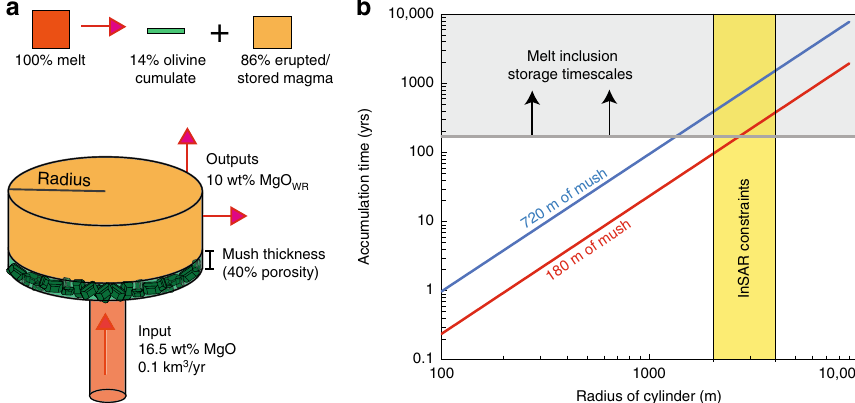
Fig. 10 Estimating mush pile accumulation rates using a simple box model. a A cylinder is supplied with primary melt (16.5 wt% MgO) at a rate of 0.1 km 3 /year (see ref. 71 ). Fractionation of these primary melts to the average whole-rock MgO contents of erupted lavas (~10 wt%) requires fractionation of 14 vol.% olivine crystals (ref. 15 ). b The play off between cylinder radius and accumulation time is shown for mush piles with thicknesses of 180 and 720 m (assuming 40% porosity). Available constraints on reservoir radius from interferometric synthetic aperture radar (InSAR) are shown in yellow (see ref. 72 ). Melt inclusion trace element diversity at K ī lauea indicates that crystals are stored in mush piles for >170 years (see ref. 70 ; gray box). These geometric and temporal constraints bracket the range of mush thicknesses estimated in this